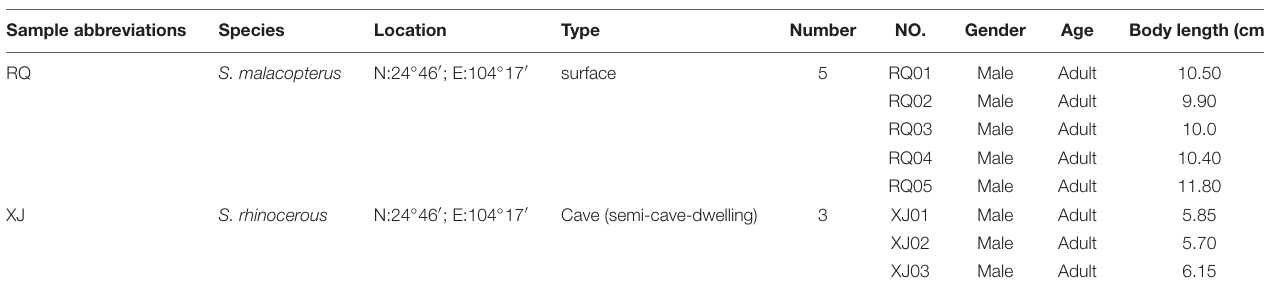
FIGURE 1 | Photographs of Sinocyclocheilus surface and cavefish. (A) S. malacopterus ; (B) S. rhinocerous. The body length and proportion of these two fish are consistent with the truly scale. TABLE 1 | Sampling details of each Sinocyclocheilus